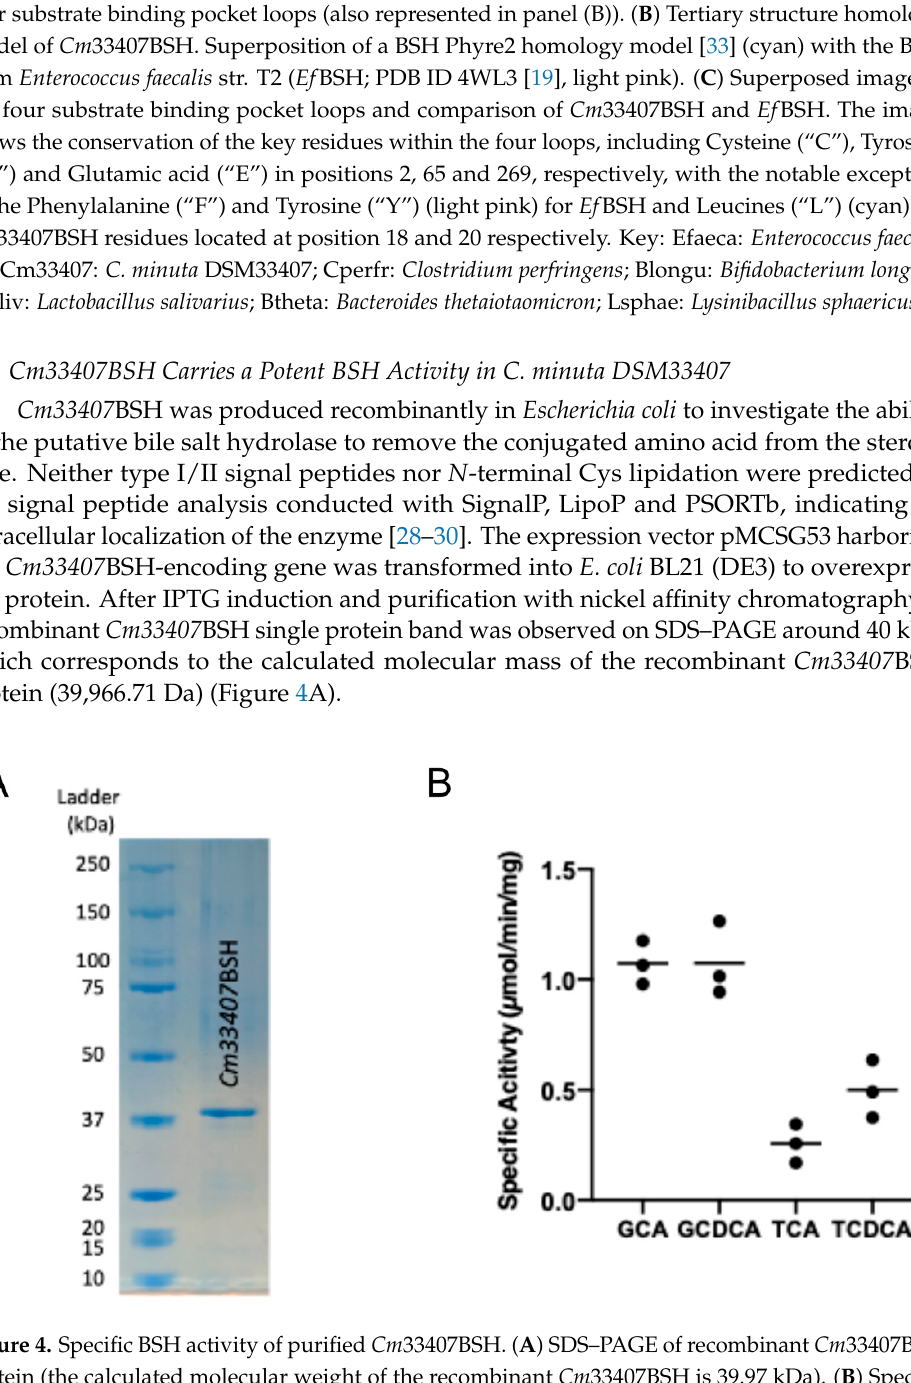
Figure 3. Alignment of the structure-based protein sequence of BSH from C. minuta DSM33407 and representative BSH and PVA members. ( A ) Full protein sequence alignment of 325 amino acids numbered. See Table S1 for accession numbers and references. Conserved residues are highlighted in red. Black stars indicate the amino acid residues that are conserved in the choloylglycine hydrolase superfamily. Black triangles indicate the amino acid residues that were shown to be im- portant in catalysis and substrate binding in previous studies [43]. The dashed black rectangles indicate the four substrate binding pocket loops (also represented in panel (B)). ( B ) Tertiary structure homology model of Cm 33407BSH. Superposi- tion of a BSH Phyre2 homology model [33] (cyan) with the BSH from Enterococcus faecalis str. T2 ( Ef BSH; PDB ID 4WL3 [19], light pink). ( C ) Superposed image of the four substrate binding pocket loops and comparison of Cm 33407BSH and Ef BSH. The image shows the conservation of the key residues within the four loops, including Cysteine (“C”), Tyrosine (“Y”) and Glutamic acid (“E”) in positions 2, 65 and 269, respectively, with the notable exception of the Phenylalanine (“F”) and Tyrosine (“Y”) (light pink) for Ef BSH and Leucines (“L”) (cyan) for Cm 33407BSH residues located at position 18 and 20 respectively. Key: Efaeca: Enterococcus faecalis T2; Cm33407: C. minuta DSM33407; Cperfr: Clostridium perfringens ; Blongu: Bifidobacterium longum ; Lsaliv: Lactobacillus salivarius ; Btheta: Bacteroides thetaiotaomicron ; Lsphae: Lysinibacillus sphaericus.